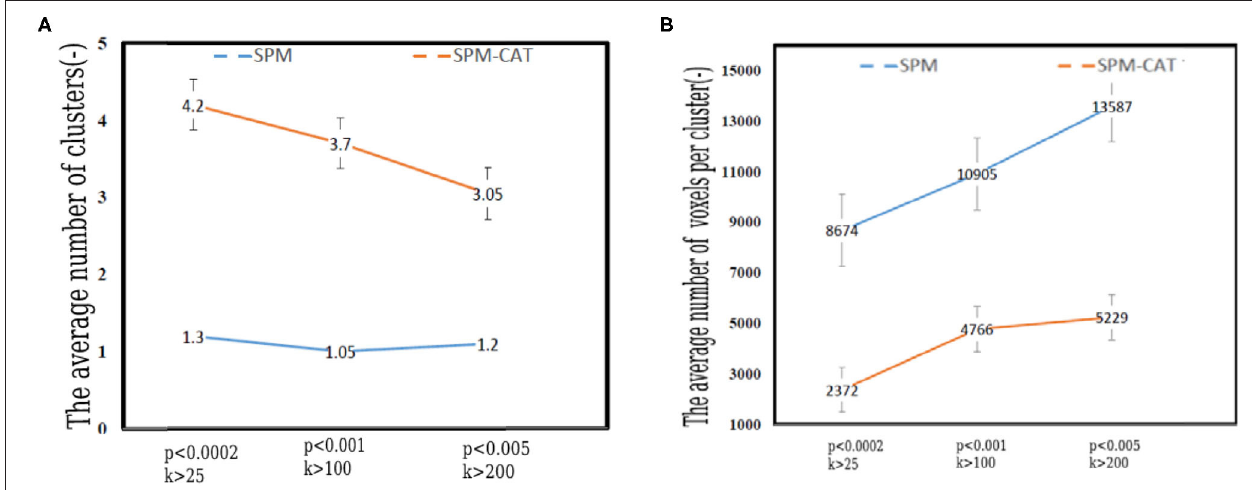
FIGURE 6 | Number and volume of clusters identified by SPM and SPM-CAT with different parameter settings. (A) The average number of clusters. (B) The average volume of per cluster (number of